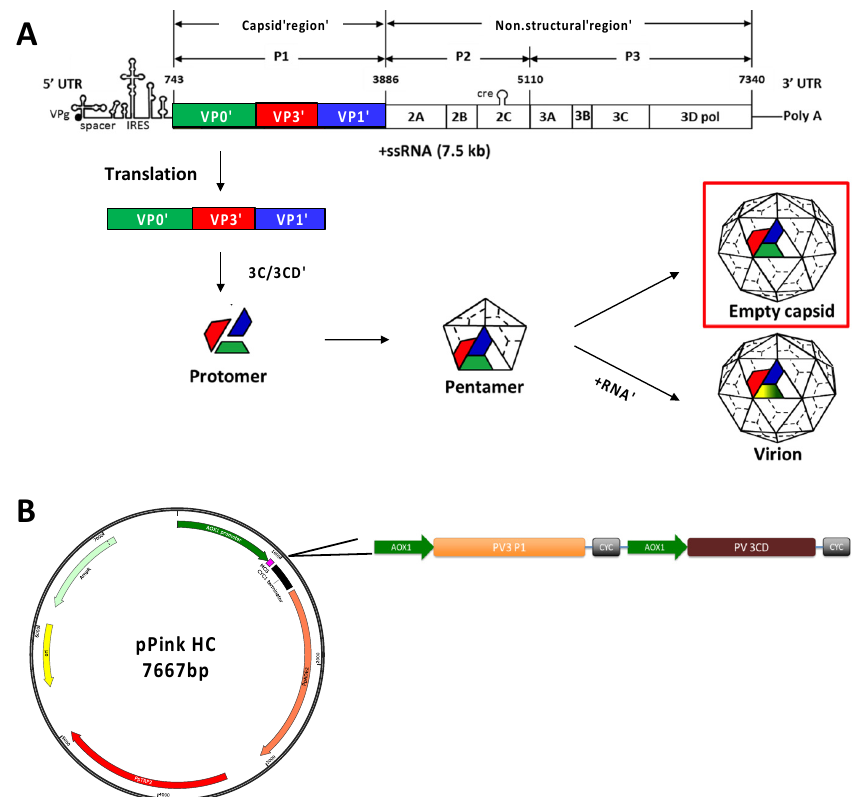
Figure 1. Schematic of poliovirus genome and expression cassette. ( A ): Schematic highlighting the structural and non-structural regions of the PV genome. The capsid region P1 is cleaved post-translationally by the viral protease (3CD) to produce VP0 (green), VP3 (red), and VP1 (blue), which form protomers, followed by pentamer formation, which culminates in the production of either virions in the presence of viral RNA or empty capsids, in which VP0 remains uncleaved. ( B ): The pPink HC expression vector with the dual alcohol oxidase (AOX) promoter expression construct, which drives the expression of the P1 capsid protein and the viral protease,